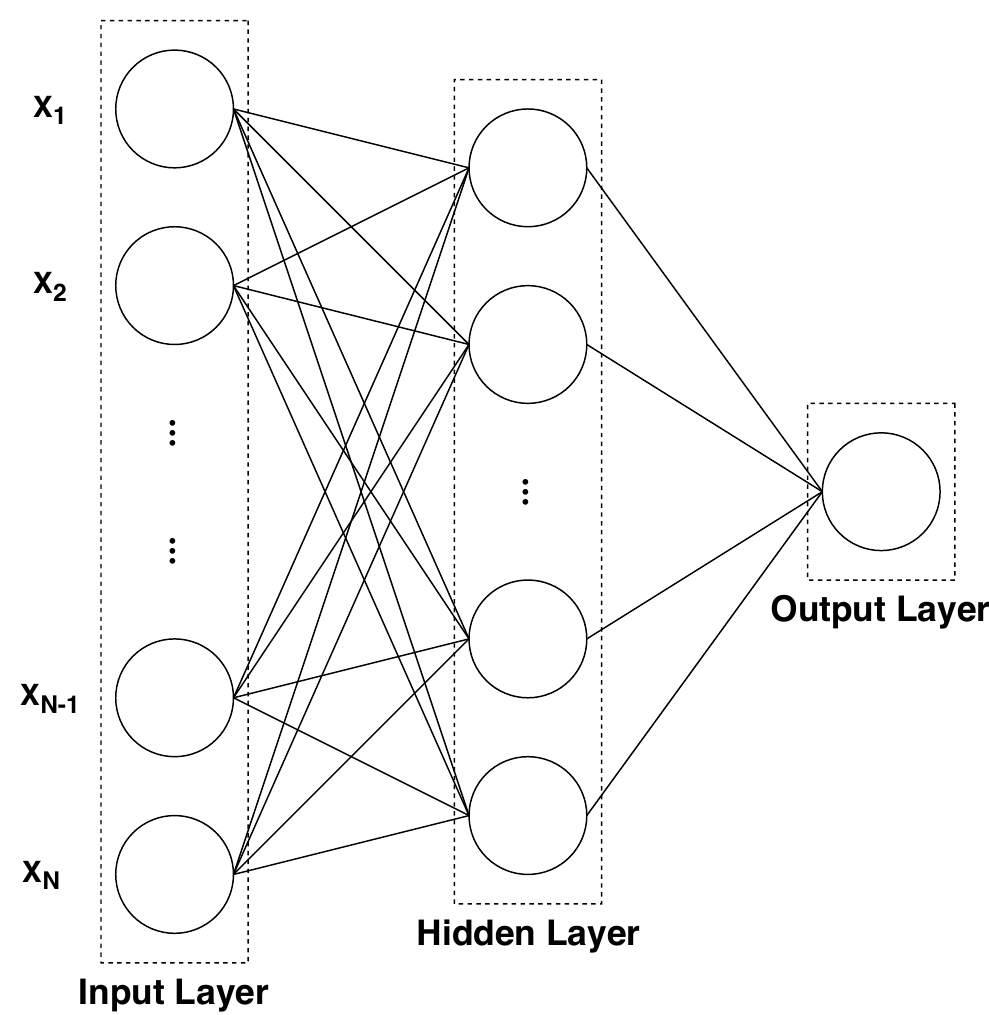
Figure 1. Artificial neural networks (ANN) structure. Note: The figure shows the ANN structure with N input nodes, a number of nodes belonging to the hidden layer and the output